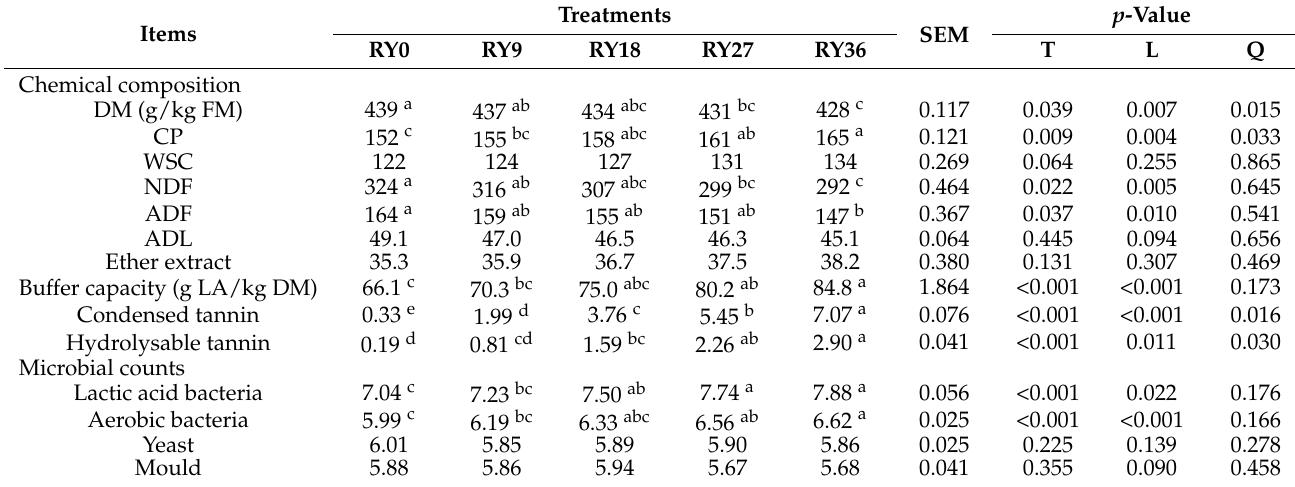
Table 2. Effect of paper mulberry replacement levels on chemical composition (g/kg DM) and microbial counts (log 10 cfu/g FM) of pre-ensiled